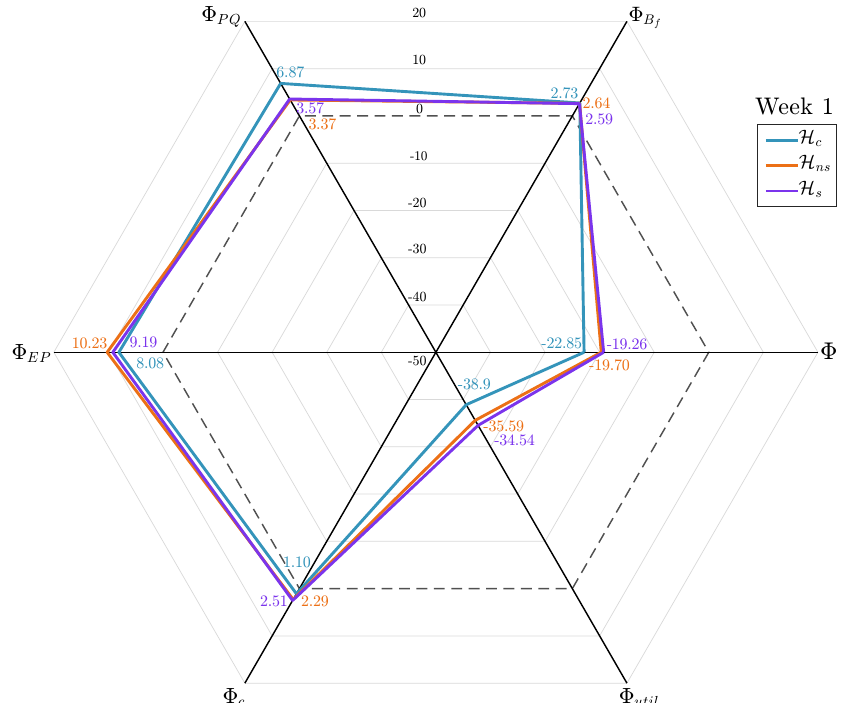
Figure 5. Energy operation economic result for Week 1. The radar plot shows the aggregate economic result ( Φ ) and its components, namely, the monetary amounts corresponding to expenses for energy imported from the utility ( Φ util ), revenue obtained from compensation for energy fed into the grid ( Φ c ), result from trading in the EP market ( Φ ) and in the PQ market ( Φ ) and the valuation of the EP PQ ) final battery energy content ( Φ B f